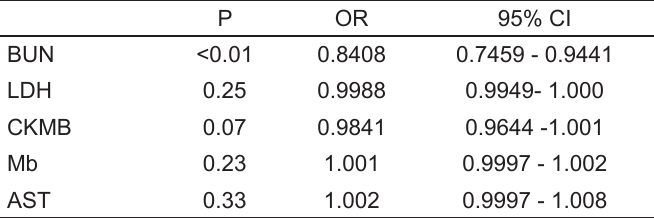
Table 6. Multivariate logistic regression models for independent factors related to patient